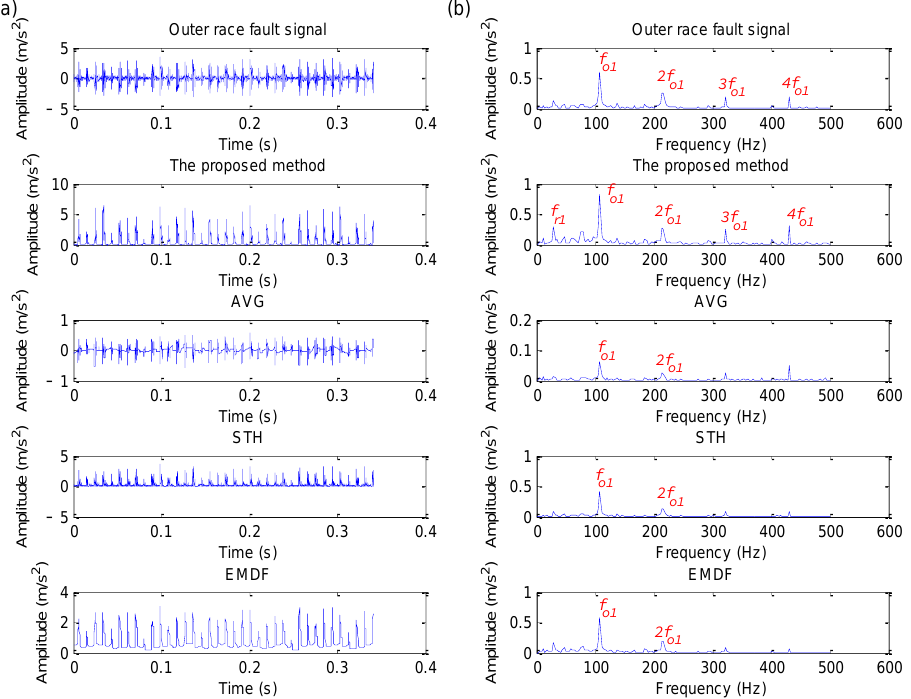
Figure 18. Analysis results obtained by different methods for dataset 130 in case 2: ( a ) Time domain waveform; ( b ) its corresponding envelope spectrum.